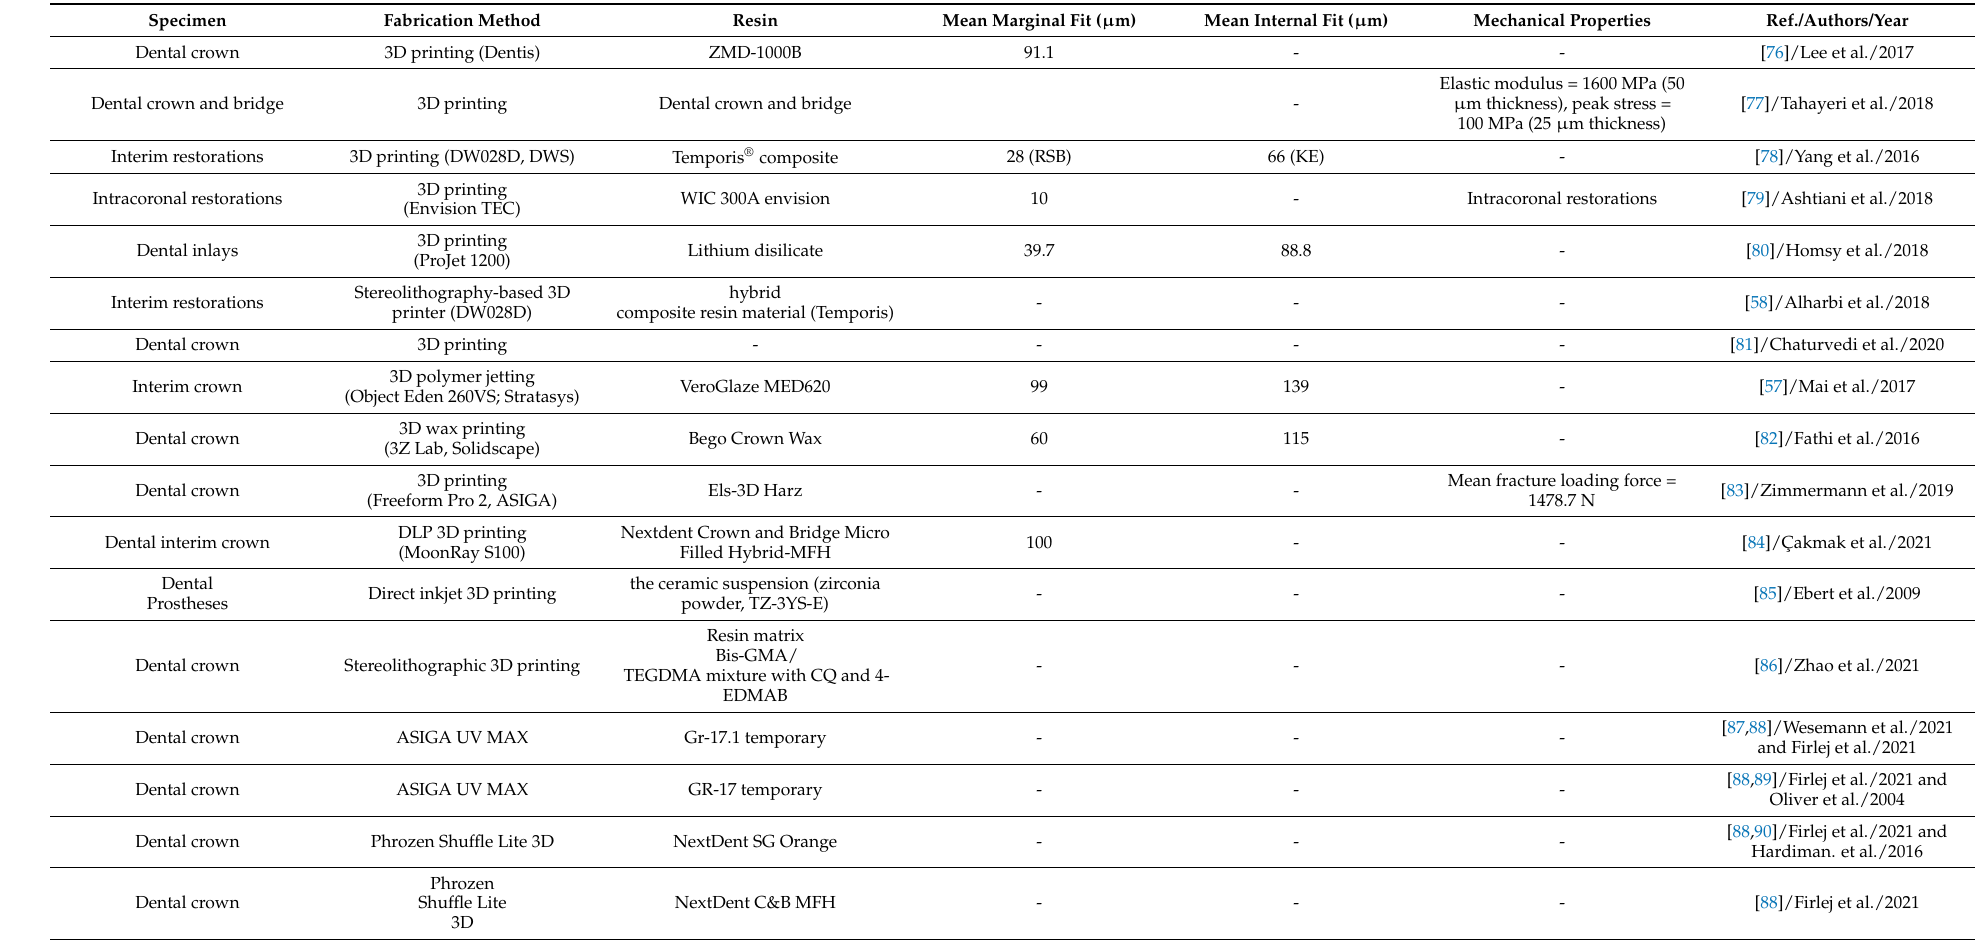
Table 2. Summary of recent 3D printing applications in dental prostheses and